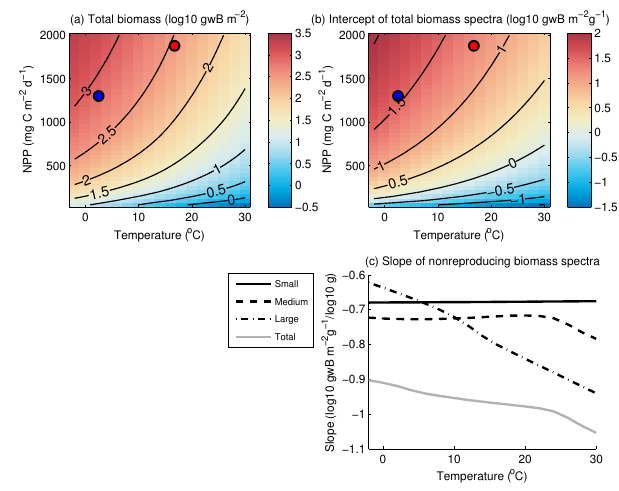
Figure 5. Model sensitivity to net primary production (NPP) and temperature ( T ). (a) Total biomass in terms of NPP and T , (b) in- tercept of total fish spectrum in terms of NPP and T , and (c) group and total slope of the non-reproducing part of the fish biomass spec- tra. In (c) , since the slopes of the biomass spectra do not depend on NPP, the slopes are lines that depend only on temperature. Red and blue circles in (a) and (b) represent the NPP and T of the warm- and cold-water sites, respectively, used in Fig. 4. All total spectral inter- cepts and slopes are calculated by adding the biomass in each mass class over all three groups. The intercept is the spectral biomass of the first mass class, and the slope is calculated from the mass classes that are smaller than the maturity mass m α,k (the non-reproducing mass